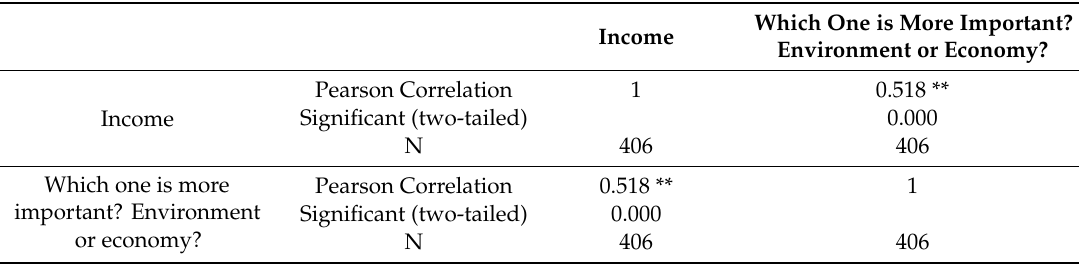
Table A1. Income correlations results.